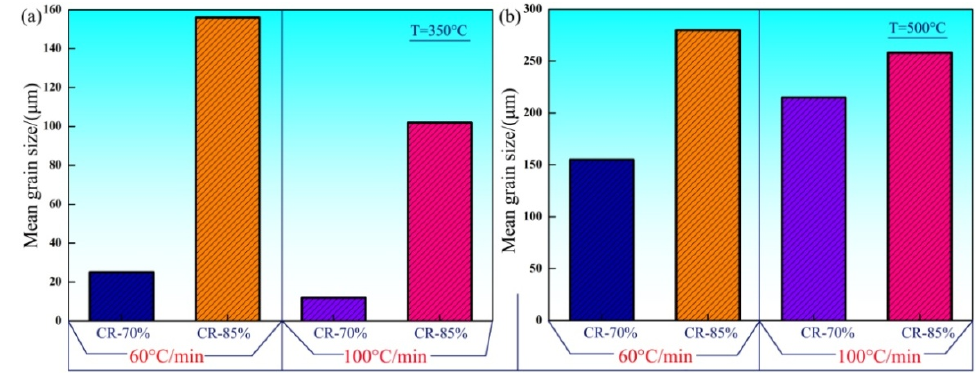
Figure 8. The mean grain size distribution of different heating rate annealing ( a ) T = 350 °C; ( b ) T = 500 °C. ( b ) T = 500 ◦